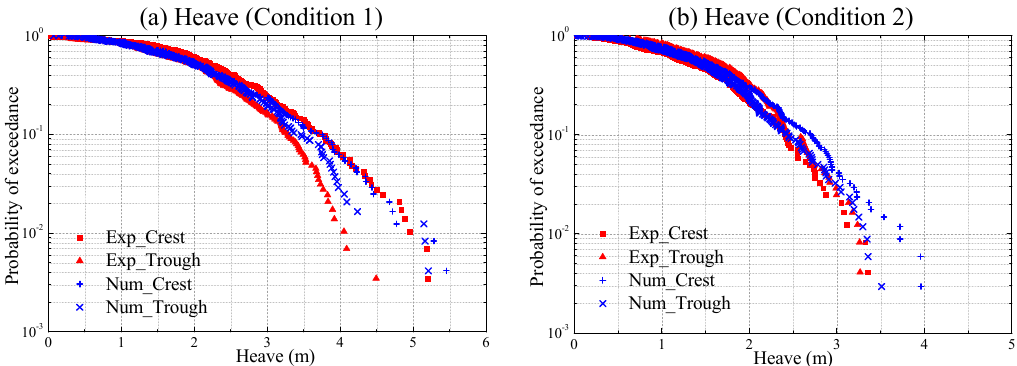
Figure 10. Comparison of probability of exceedance of heave motion.